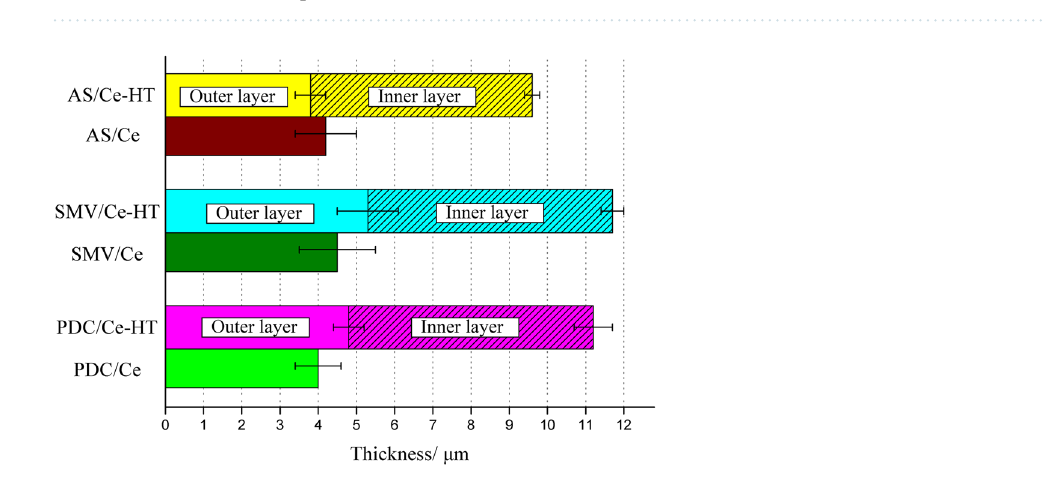
Figure 11. The cross-sectional SEM images and corresponding EDS mappings of ( a ) PDC/Ce-HT, ( b ) SMV/ Ce-HT and ( c ) AS/Ce-HT specimens.